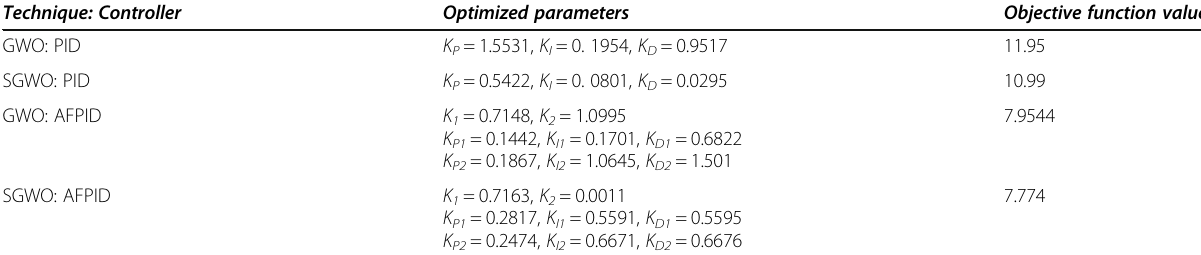
Table 8 SGWO and GWO tuned PID and AFPID parameters Technique: